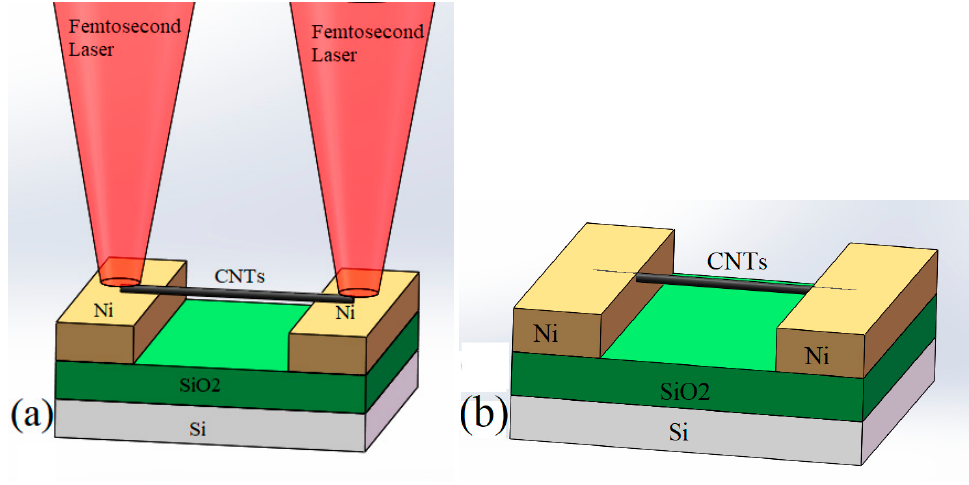
Figure 1. Schematic diagrams of laser irradiation connect process: ( a ) before irradiation; ( b ) after irradiation.